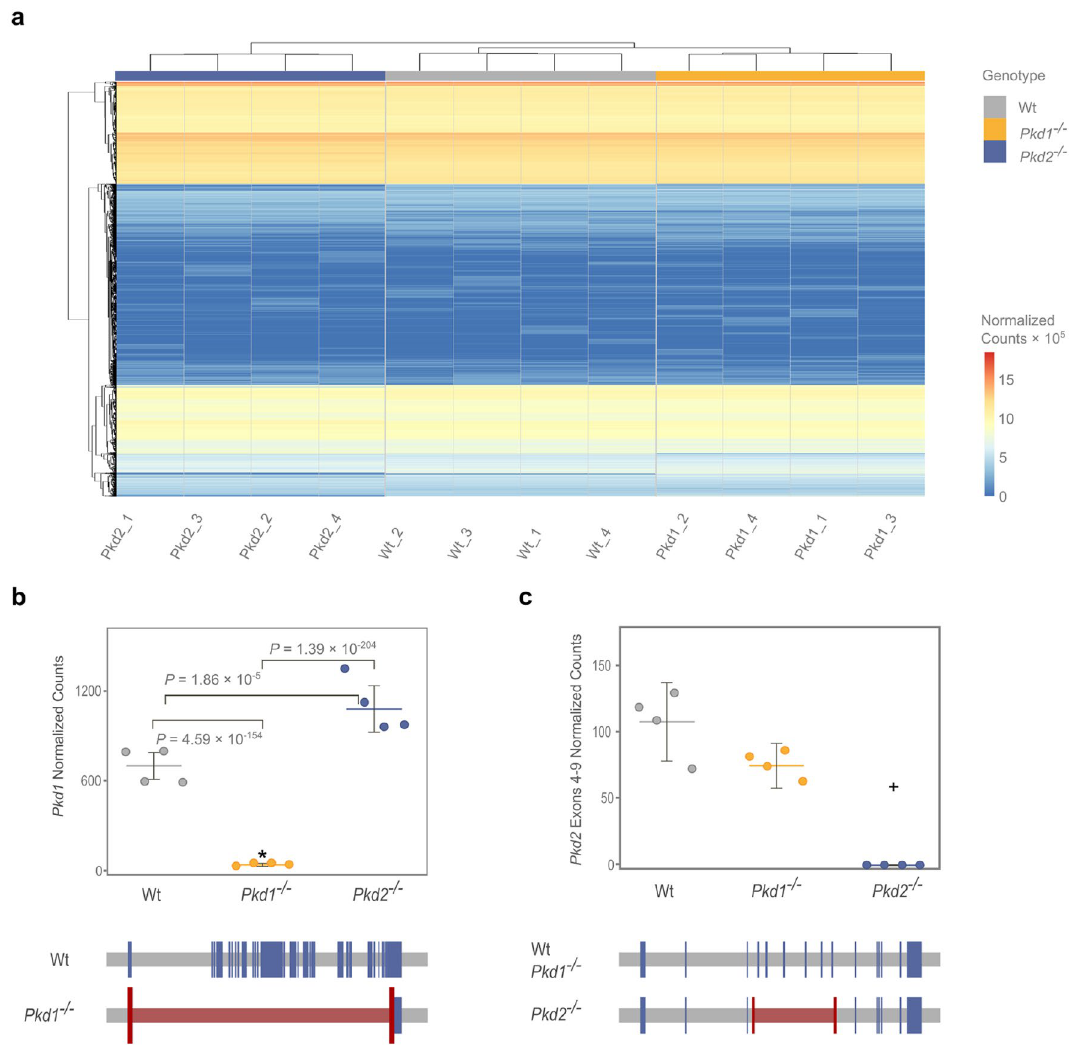
Figure 2. Transcriptomic profiling of genetically engineered ADPKD cells showed significant interdependence of Pkd1 and Pkd2 mRNA expression. ( a ) Unsupervised hierarchical clustering showed low variability and genotype-dependent grouping of mIMCD3 Wt, Pkd1 −/− and Pkd2 −/− cells. ( b ) Pkd1 knockout was generated by a full genomic deletion. Loss of Pkd2 was associated with a significant transcriptional up-regulation of Pkd1 mRNA (782.25 [SEM = 97] mean normalized counts in wildtype vs. 1,209 [SEM = 175] in Pkd2 −/− cells). ( c ) Pkd2 knockout was based on genomic deletion of Pkd2 exons 4–9 and no counts were detected for these exons. + : adjusted p-values for single exons 4–9 were < 1.75 × 10 –51 in Pkd2 −/− versus Wt and Pkd2 −/− versus Pkd1 −/− responsive transcription 18,19 . We hypothesized that the integrative analysis of PKD1- and PKD2- deficiency may substantially improve the high-confidence identification of consistent transcriptional changes in ADPKD patho- genesis. Technically, the low biological variability of wild-type, Pkd1 −/− and Pkd2 −/− mIMCD3 cells provided a sound basis to delineate ADPKD-specific renal tubular transcription (Figs. 2a, S2a–e). This was important, as gene expression is an inherently stochastic process and is known to vary even between cells of the same population 29 . In general, observed variations in gene expression can be decomposed as 30,31 : Var (cid:31) Expr (cid:30) = Across group variability + Measurement error + Biological variability. With group variability being here the variation in gene expression due to the three genotypes under consid- eration. Measurement error being rather low in next-generation RNA-seq 32 . And biological variability being in our experiments restricted to stochastic cell-to-cell variation; and, therefore, minimal in comparison to tissue or cell type variability in whole organ analyses 31 . Thus, our approach of repeated sampling, high data quality and model simplicity should minimize the confounding effects of measurement error and biological variability, focusing generated data on the primary outcome of interest: the estimated Pkd-dependent difference in gene expression between genotypes.